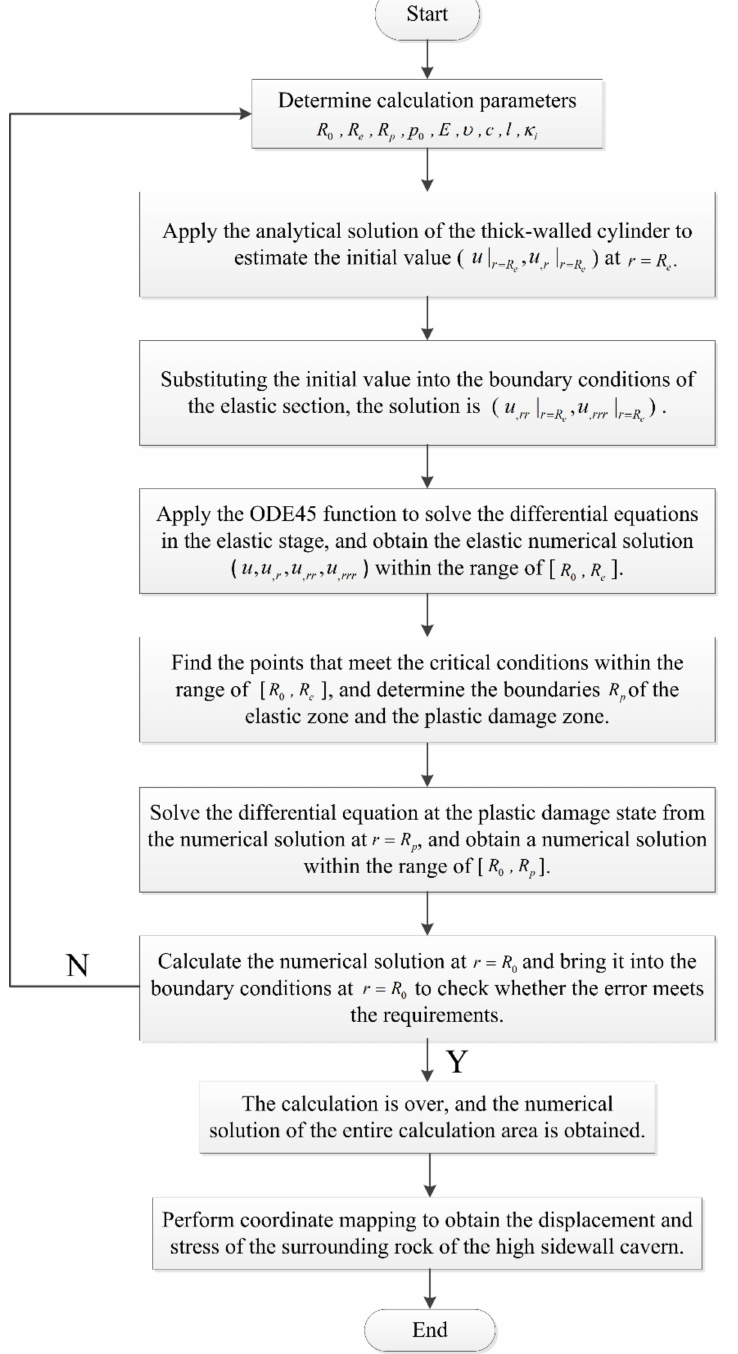
Figure 7. The calculation flow chart of the solution